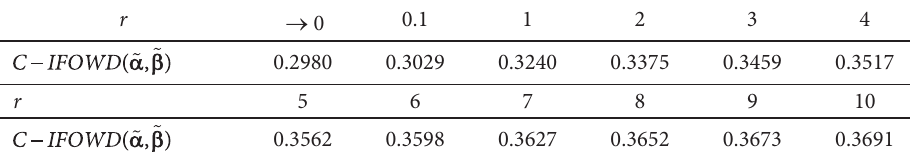
Table 1. Aggregation